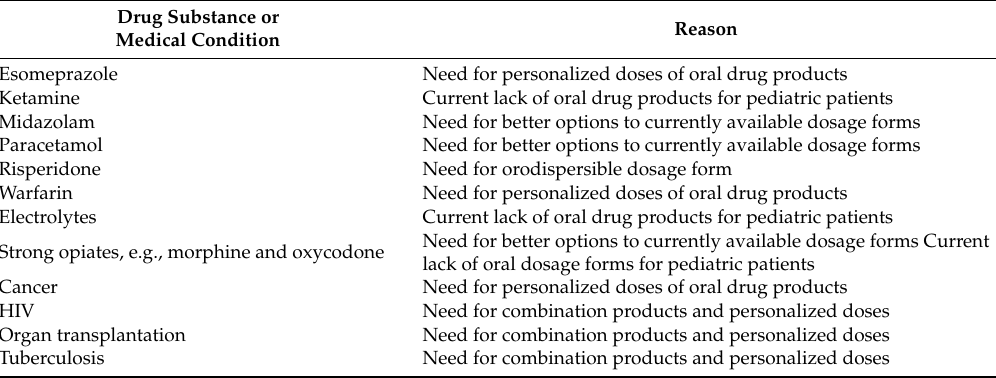
Table 4. Suggestions made by the focus group participants on drug substances and medical conditions where 3D-printed drug products would be